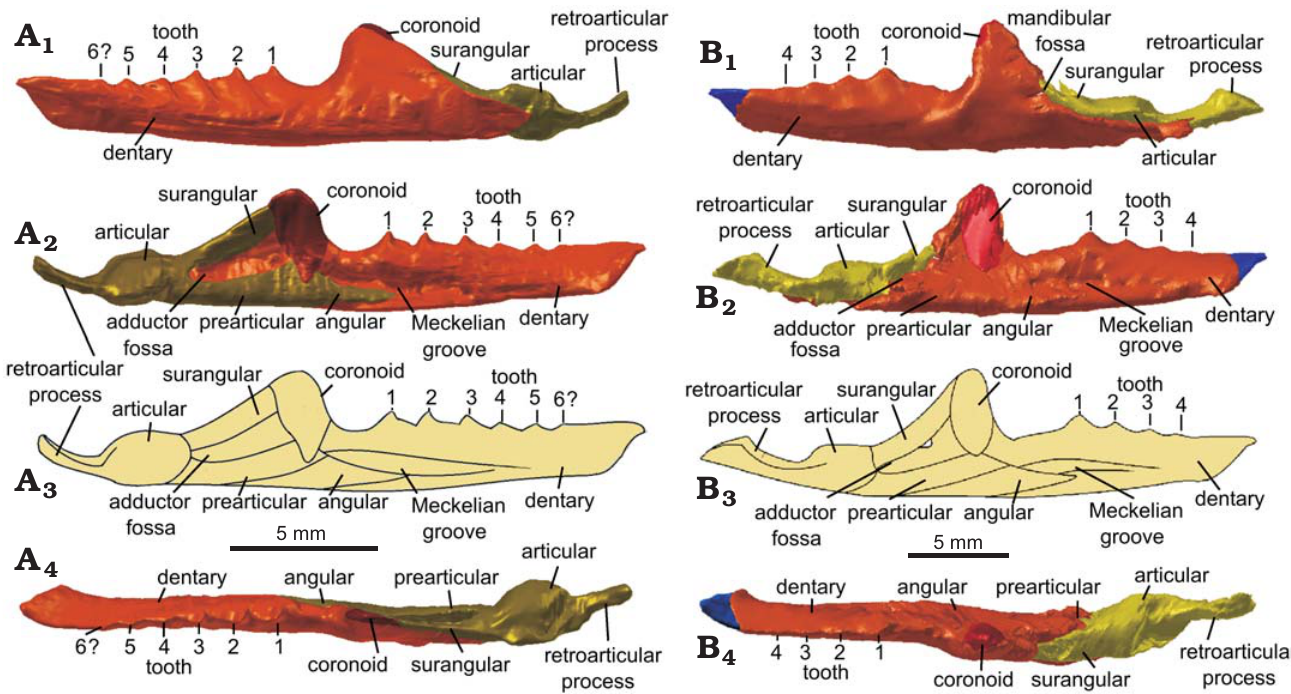
Fig. 10. The reconstructed left mandible of lepidosaur rynchocephalians. A . Clevosaurus cambrica Keeble, Whiteside, and Benton, 2018 (NHMUK PV R37014) from Late Triassic, Pant-y-ffynnon, Wales, UK. B . Clevosaurus hudsoni Swinton, 1939 (NHMUK PV R36832) from Rhaetian, Cromhall Quarry, England, UK. Note: the anterior tip of the dentary is highlighted in blue to indicate where bone is taken from C. cambrica . In lateral (A 1 , B 1 ), medial (A 2 , B 2 ), and dorsal (A 4 , B 4 ) views, simplified reconstruction in medial view (A 3 , B 3